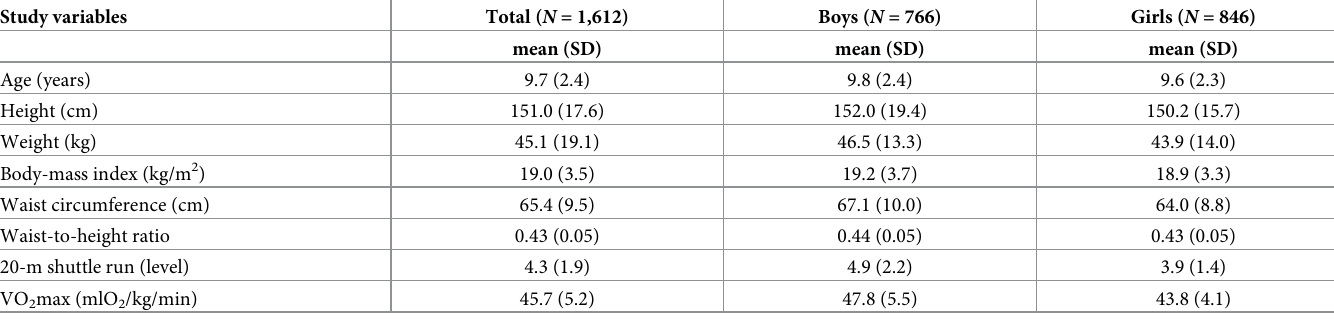
Table 1. Basic descriptive statistics of the study participants ( N =